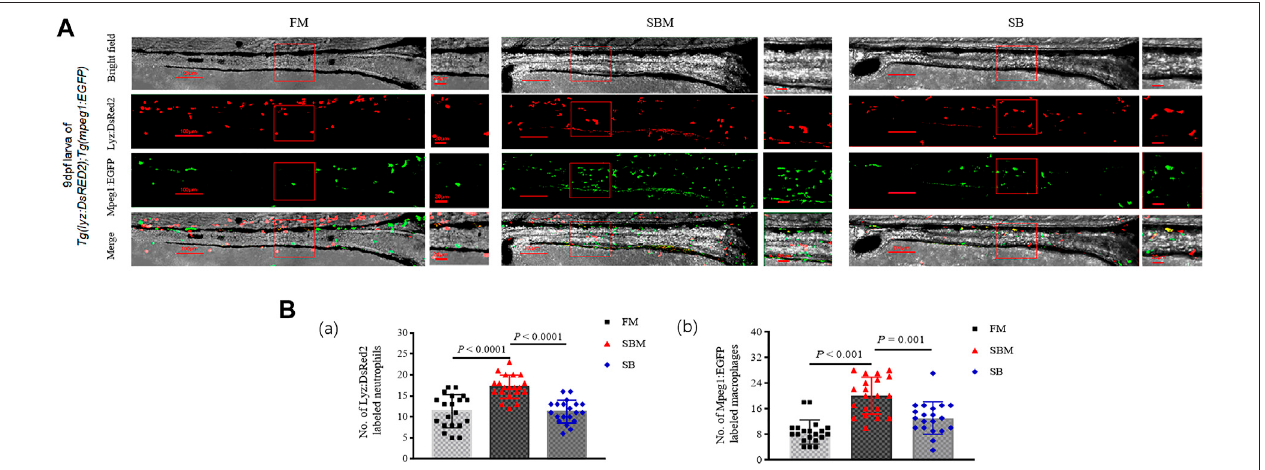
FIGURE6| Imagingofinnateimmunecellsandexpressionalanalysisofimmune-relatedgenesinzebra fi shSBMIElarvamodel. (A) lyz:DsRED2labeledneutrophils andmpeg1:EGFPlabeledmacrophagesimagingintheintestine(posteriorpart, n =10)using9 dpflarvaeof Tg(lyz:DsRED2) ; Tg(mpeg1:EGFP) .Thesquareindicatedthe zoomed in region. The scale bar in whole pictures was 100 μ m, while the scale bar in the enlarged view was 20 μ m. (B) quantitative analysis of the signals using bar- diagrams. (a) NumberofLyz:DsRed2labeledneutrophilsinlarvaefromeitherFM,SBM,orSBgroups; (b) No.ofMpeg1:EGFPlabeledmacrophagesinlarvaefrom either FM, SBM, or SB groups. The very signi fi cant differences ( p < 0.01) of both Lyz:DsRed2 and Mpeg1:EGFP labeled cells between SB and SBM groups were indicated by p-